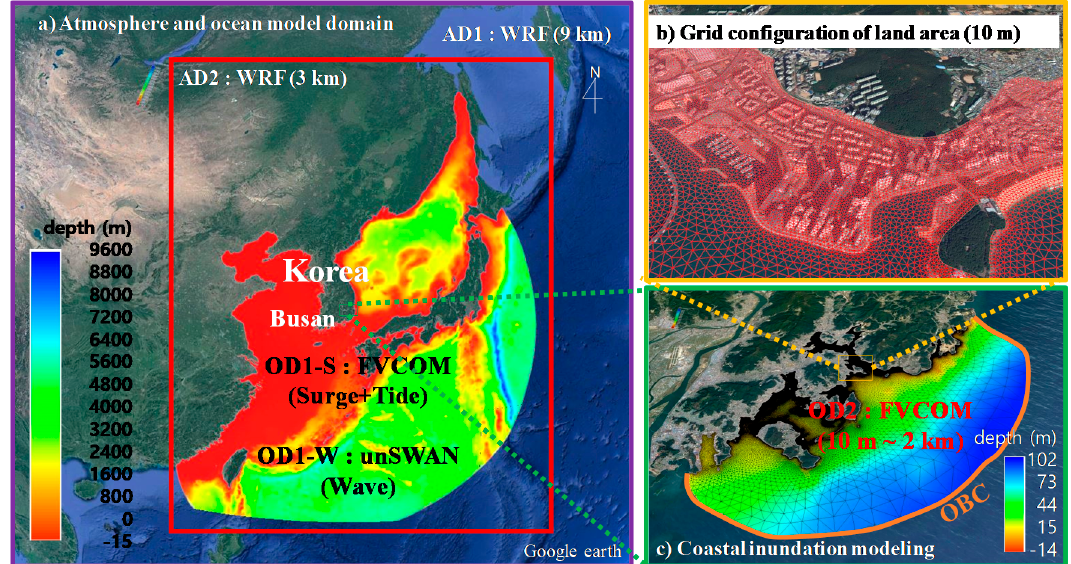
Figure 2. Model description for simulation of typhoon-induced coastal inundation (AD: Atmosphere Domain, OD: Ocean Domain).